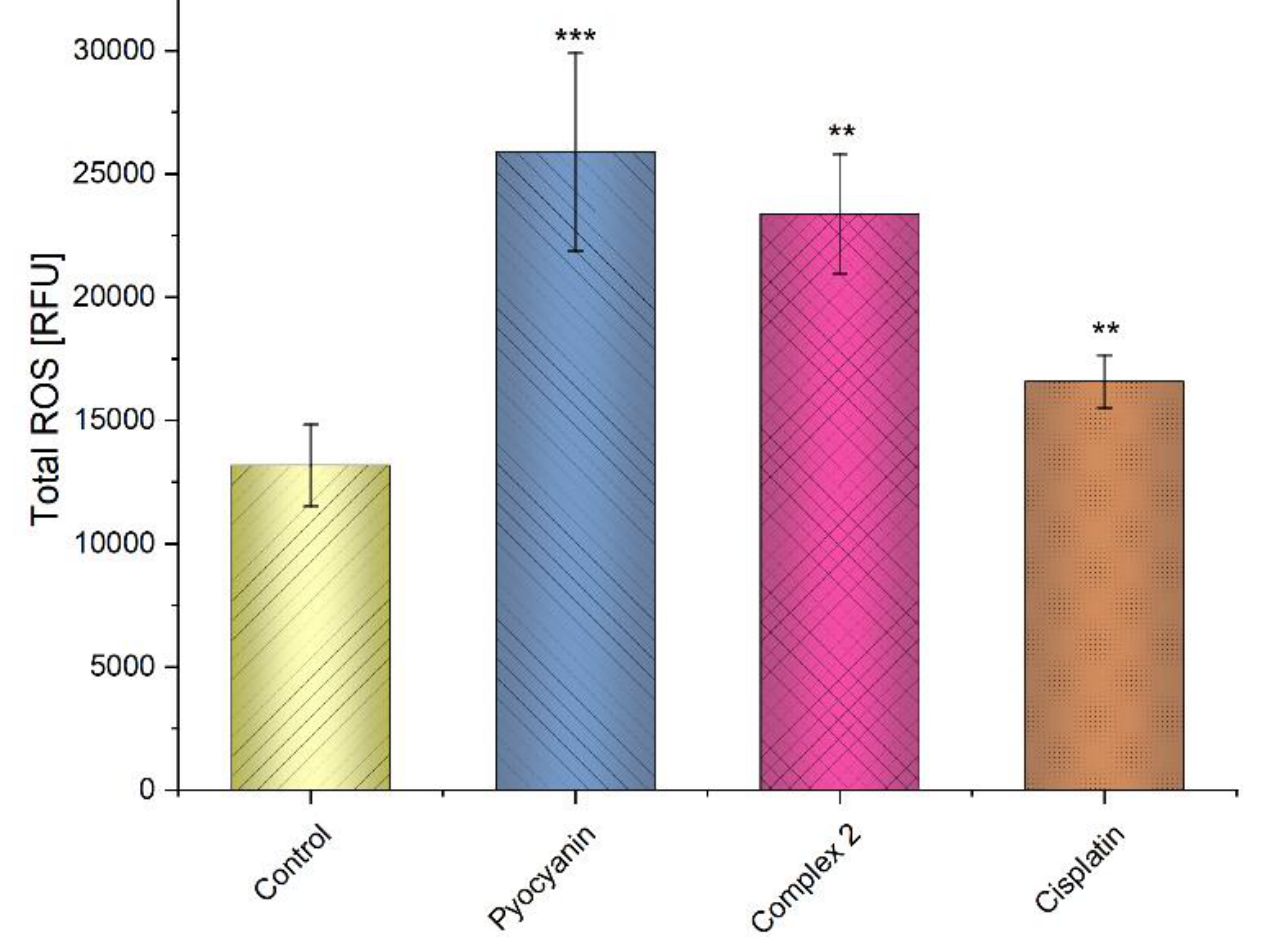
Figure 9. The effects of complex 2 (3 µ M), reference drug cisplatin (19 µ M), and well-known inductor of ROS production pyocyanin (100 µ M) on the total ROS production in the A2780 cell line. Cells were treated by the tested compounds, or by the vehicle (0.1% DMF) in the control sample for 1 h. *** indicates statistical significance at the p < 0.005 level and ** p < 0.01 levels compared to the control.